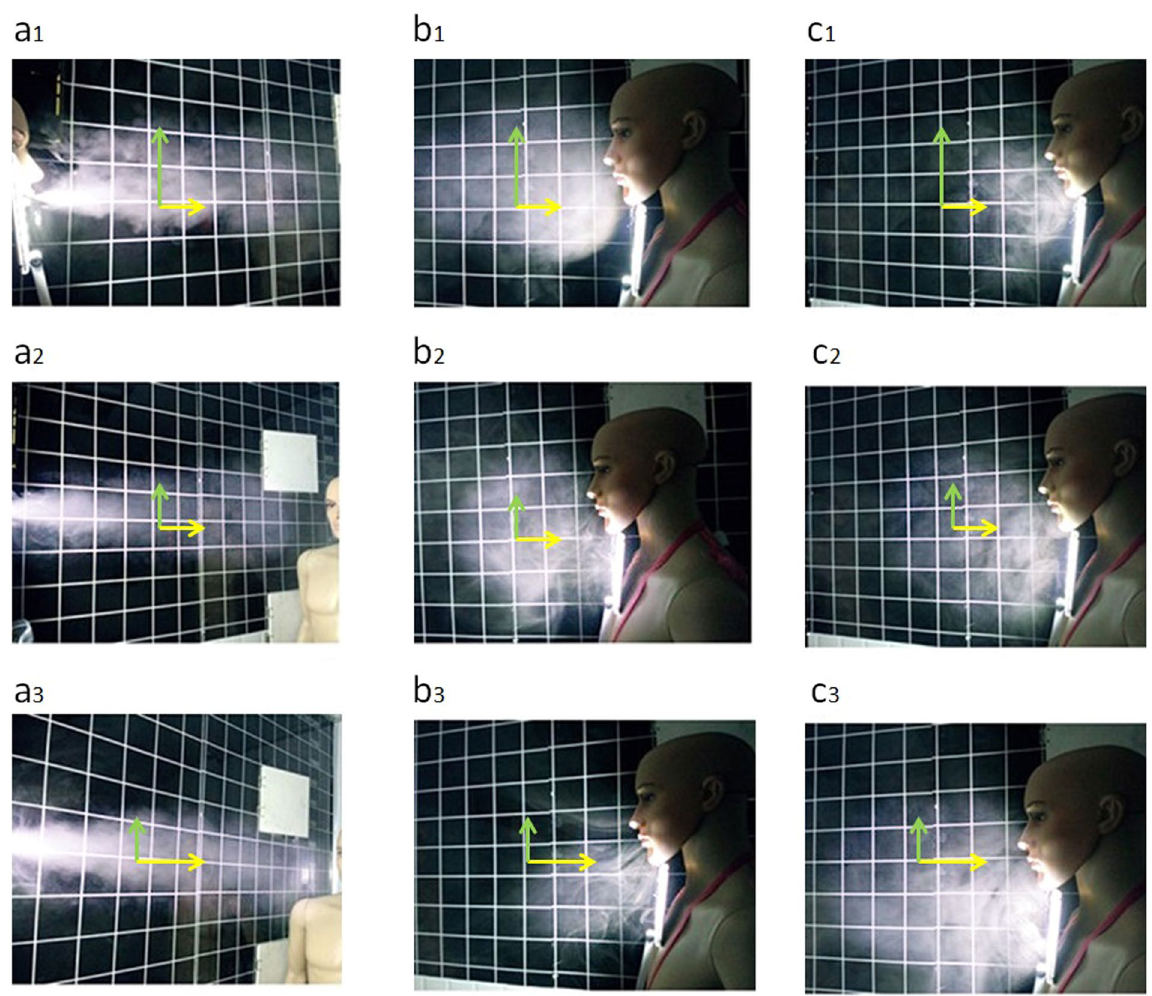
Figure 2. Turbulence diffusion and inertia accumulation caused by temperature background effect under three different inertia stability cases (unstable, neutral, stable) on interactive respiration process. In model experiment, distance between two manikins is 1 m, and the size of mouth and nose is 112 mm 2 each; the height of the room L is 2.6 m; the initial velocity v 0 is 3.9 m/s; the temperature around exhaling and inhaling area is 286 K; in unstable case (a 1 , a 2 , a 3 ), the vertical temperature gradient is − 0.04 T/100 m, with the given temperature on the top of the room T t is 284.1 K, and the given temperature at the bottom of the room T b is 3 ′ = . × − , which indicates that turbulence diffusion is strengthened, and inertia 288.1 K, G c = 119.94, G 8 3 10 c transmission and accumulation is weakened; in neutral case (b 1 , b 2 , b 3 ), the vertical temperature gradient is 0.003 T /100 m, with the top temperature T t is 286.1 K, and the bottom temperature T b is 285.8 K, G c is ∞ , ′ = G 0 , which indicates that the turbulence diffusion and inertia transmission and accumulation have not been c affected by the temperature or density difference; in stable case (c 1 , c 2 , c 3 ), the vertical temperature gradient is 0.04 T/100 m, with the top temperature T t is 288.1 K, and the bottom temperature T b is 284.1 K, G c = − 119.94, 3 , which indicates that turbulence diffusion is weakened, and inertia transmission and ′ = − . × − G 8 3 10 c accumulation is strengthened; ( a ) Temperature background effect on expiration process. The exhaling velocity v ex = 3.9 m/s, inhaling velocity v in = 3.9 m/s, showing turbulence diffusion gets weakened as inertia effect gets stronger. ( b ) Temperature background effect on aspiration process. v ex = 3.9 m/s, v in = 3.9 m/s, showing compared with other cases in this section, smoke in stable type(b 3 ), powered by a stronger turbulence diffusion, experiences a more obvious upward movement. ( c ) The effect of aspiration velocity on interactive respiration process. v ex = 3.9 m/s, v in = 1.7 m/s, showing that compared with b, as aspiration velocity decreasing, the amount of smoke inhaled by manikin is also decreasing, leading to inertia accumulation of smoke near the mouth of aspiration